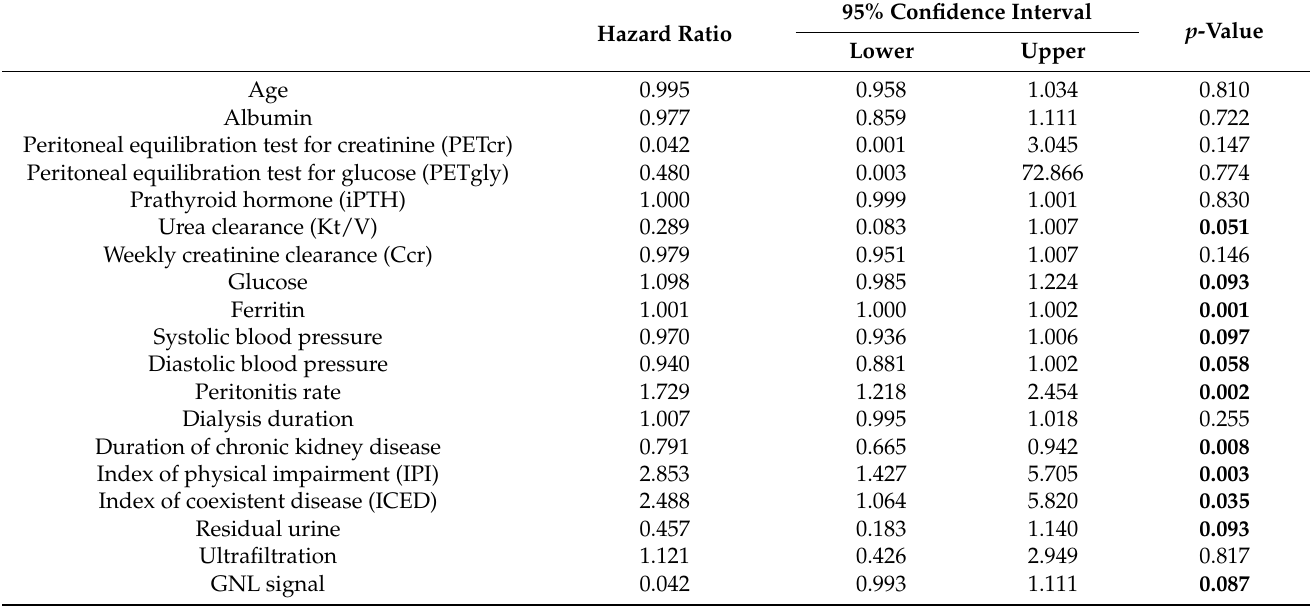
Table 3. Univariate Cox proportional-hazards analyses for predictors of lethal outcome. Survivors ( n = 39) and non-survivors ( n = 13). Significant differences are given in